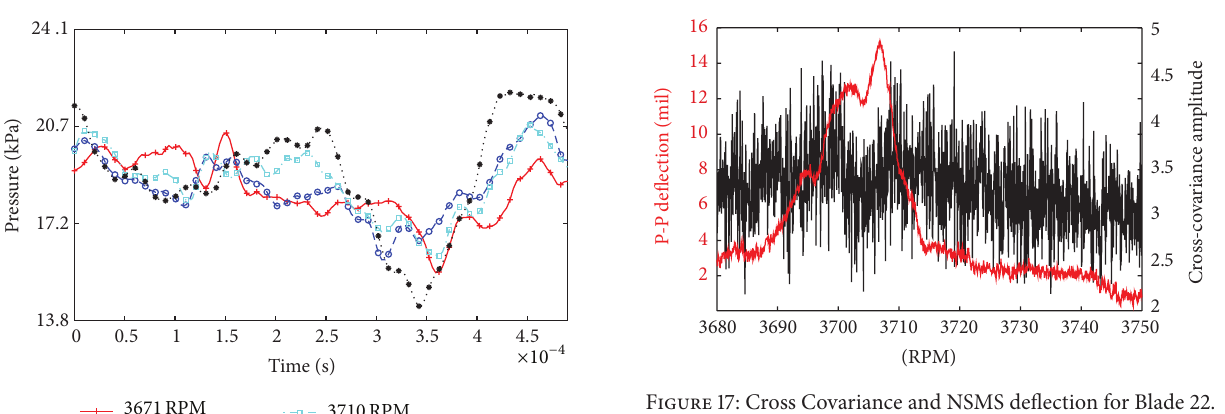
Figure 17: Cross Covariance and NSMS deflection for Blade